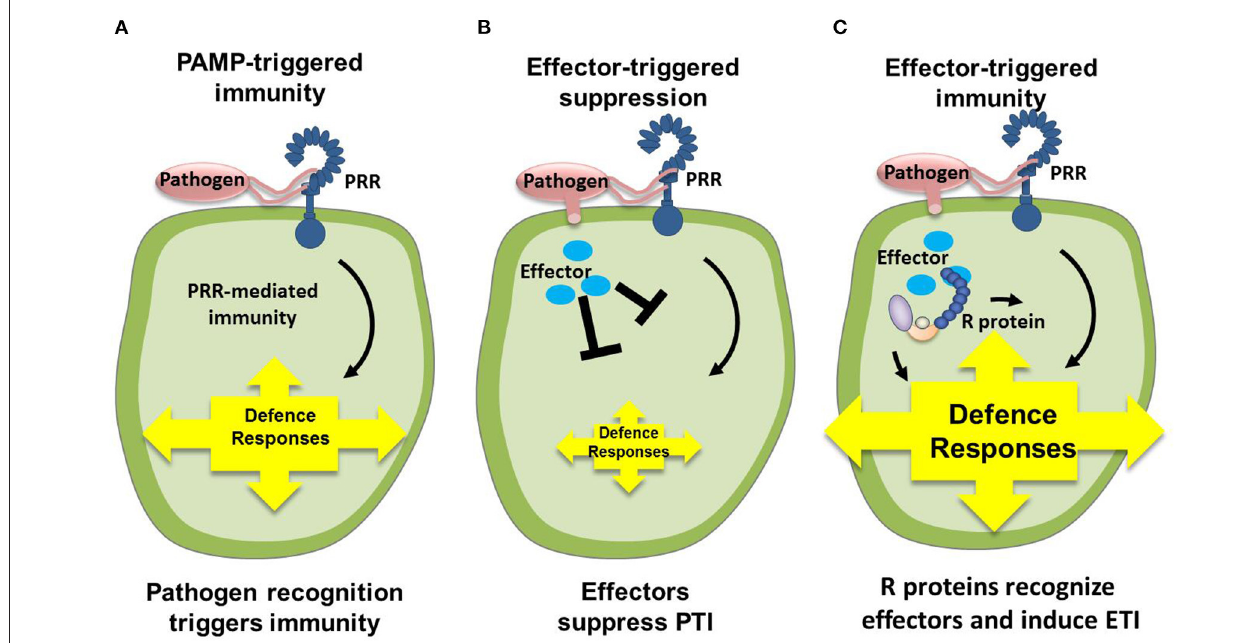
FIGURE 3 | Interaction pattern between phytopathogenic fungi and plants (Pieterse et al., 2009; Cobos et al., 2019). (A) Upon pathogen attack, PAMPs activate PRRs in the host, resulting in a downstream signaling cascade that leads to PTI. (B) Virulent pathogens have acquired effectors (blue ellipses) that suppress PTI, resulting in ETS. (C) In turn, plants have acquired R that recognize these attacker-specific effectors, resulting in a secondary immune response called ETI. PAMP, pathogen-associated molecular patterns; PRR, pattern-recognition receptors; PTI, PAMP-triggered immunity; ETS, effector-triggered susceptibility; R, resistance proteins; ETI, effector-triggered